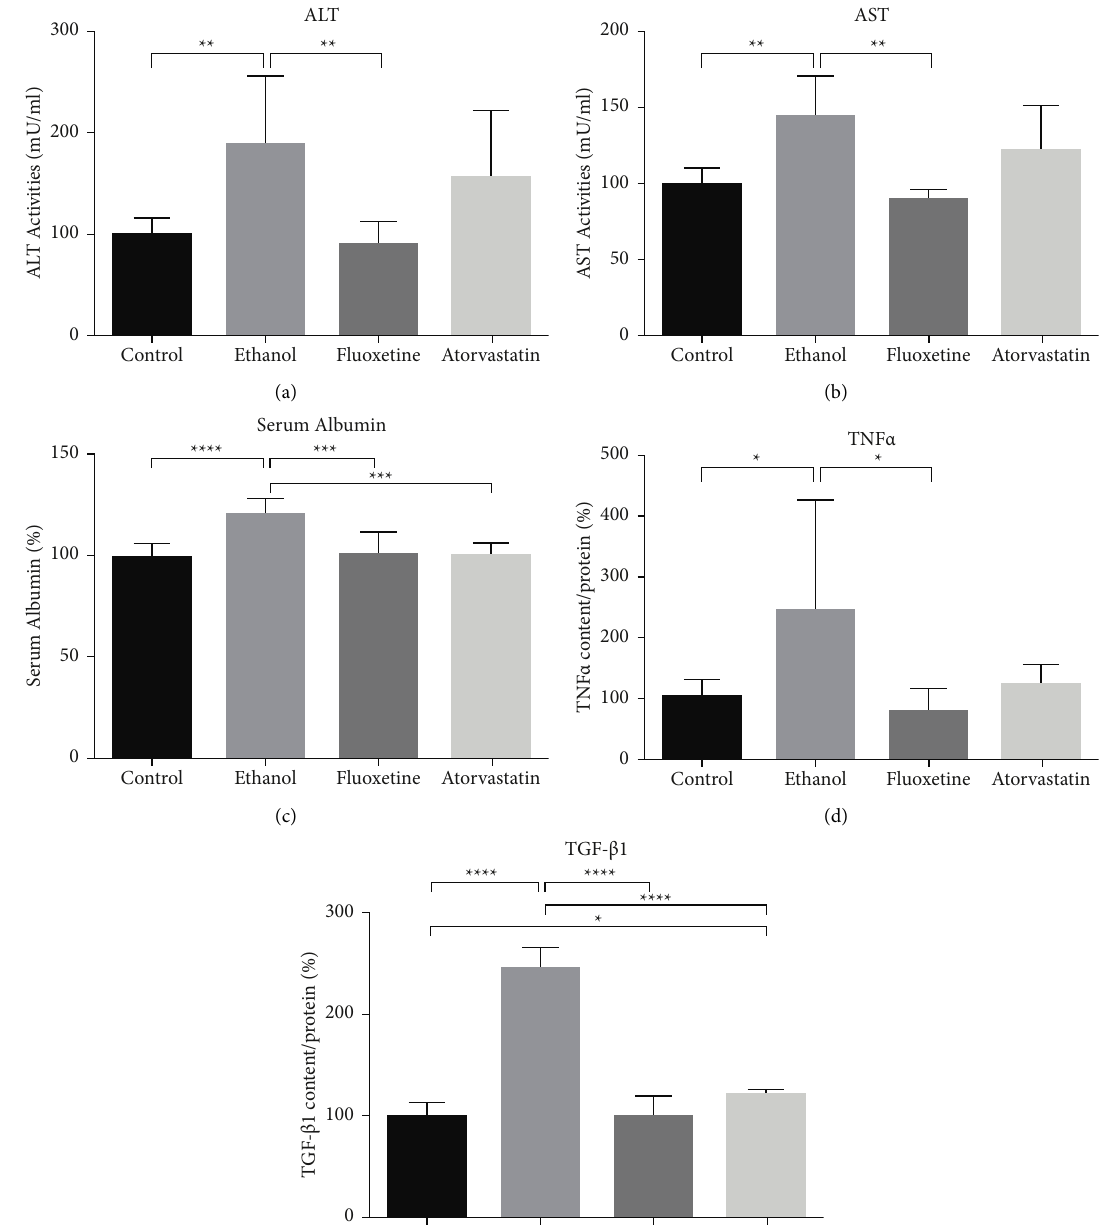
Figure 1: ALT activity (a), AST activity (b), serum albumin level (c), TNF alpha level (d), and TGF beta 1 level (e) of saline-, ethanol fluoxetine-, and atorvastatin-treated mice, respectively. Results are shown as mean ± SD; ∗ denotes P ≤ 0 . 05; ∗∗ denotes P ≤ 0 . 01; ∗∗∗ denotes P ≤ 0 . 001; and ∗∗∗∗ denotes P ≤ 0 .